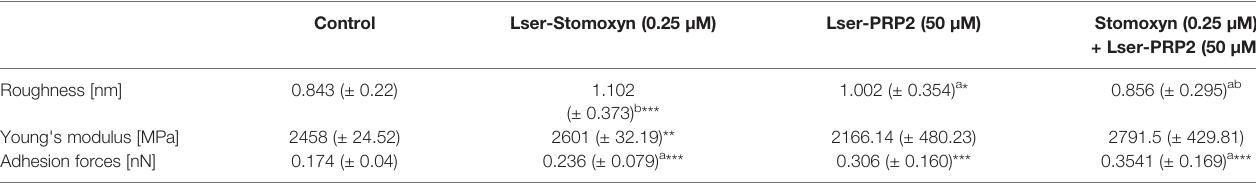
The bacteria were incubated alone (control) or in the presence of Lser-stomoxyn (0.25 µM) or Lser-PRP2 (50 µM), or both and then analyzed by atomic force microscopy. The results are presentedasmeansof25 fi eldsfromeachsample±standarddeviation(SD).Thesamelettersindicatestatisticallysigni fi cantdifferencesbetweenthepeptide-treatedexperimentalgroups (Mann-Whitney U test). The asterisks indicate statistically signi fi cant differences of the peptide-treated bacteria compared to controls (*p < 0.05; **p ≤ 0.01; ***p ≤